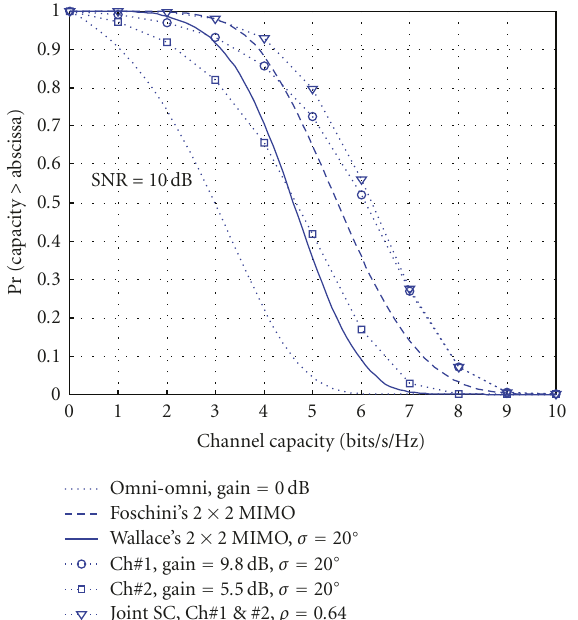
Figure 11: Outage rates of channel capacity at 3 bits/sec/Hz for both BF and MIMO systems in di ff erent